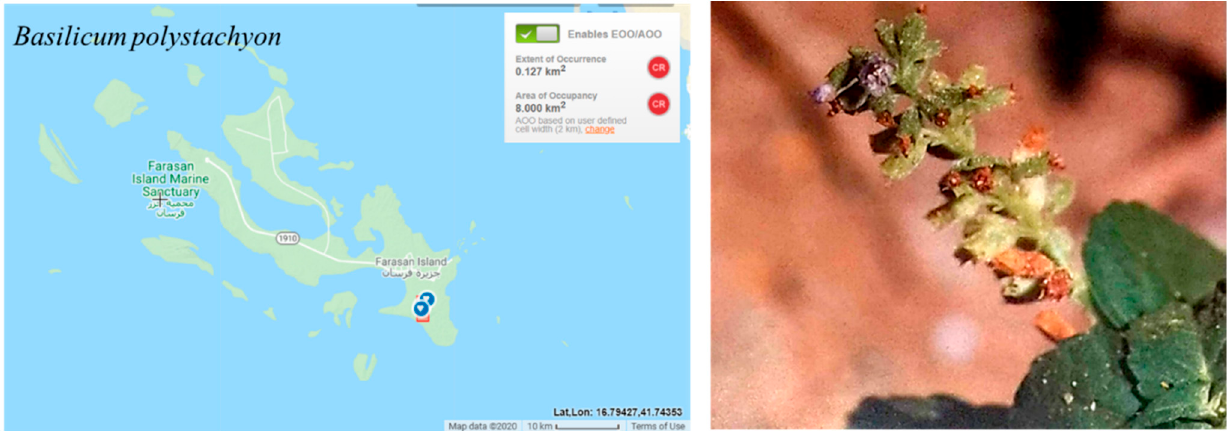
Figure 9. Geographical distribution of Basilicum polystachyon in the Farasan Archipelago. Plant photo reproduced with permission from Collenette [7] .